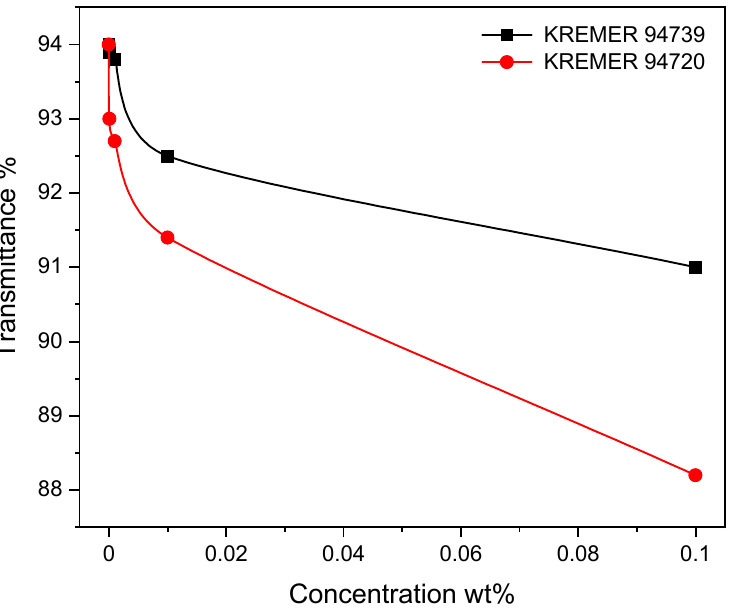
Figure 4. Effect of dye concentration on the optical transmittance for Photoselective PMMA greenhouse films doped with perylene dyes KREMER 94720 and KREMER 94739. Table 1. Optical transmission spectra at the cut-off wavelength T cut-off ( % ) and infrared efficiency η IR ( % ) for photoselective PMMA greenhouse films doped with perylene dyes KREMER 94720 and KREMER 94739.